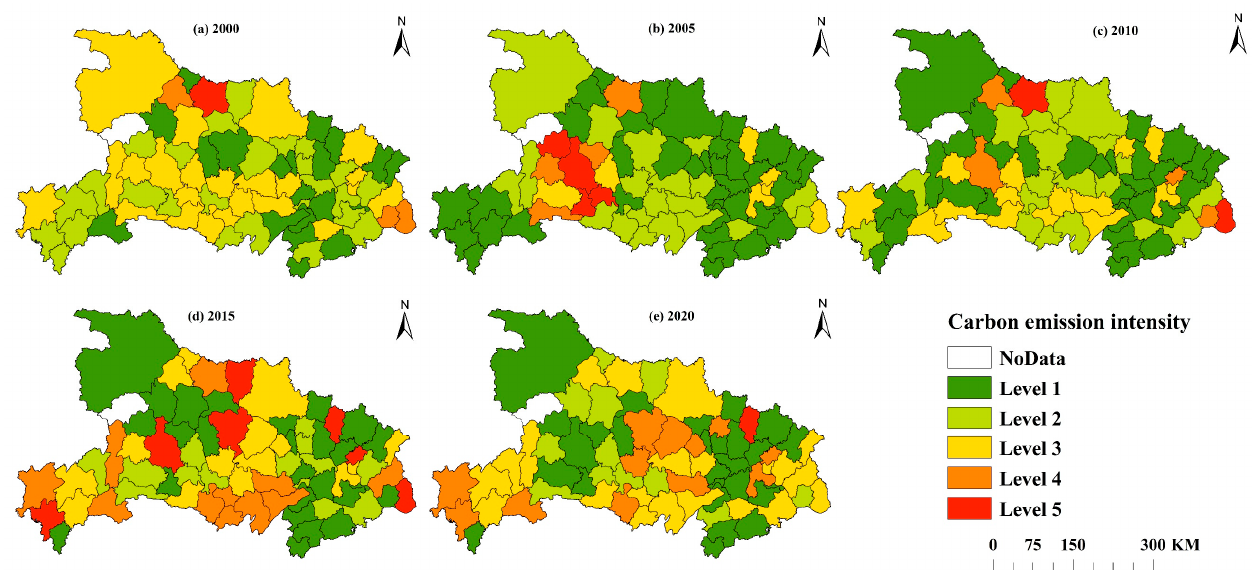
Figure 7. Spatial distribution of carbon emission intensity in Hubei Province (2000–2020).